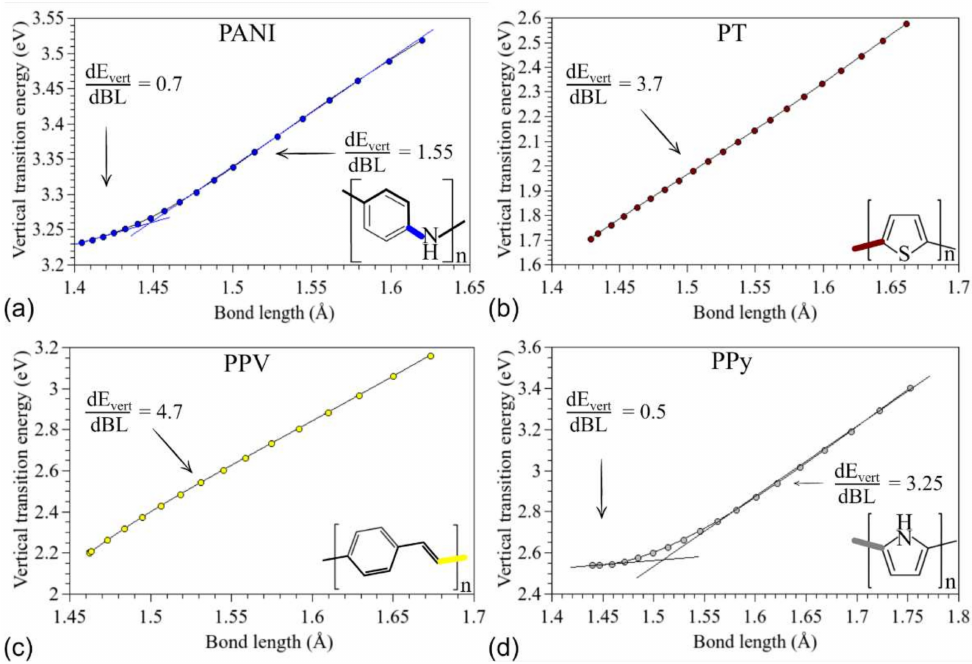
Figure 9. Relationships between the vertical transition energies and the most affected connections in the stretching process: ( a ) PANI, ( b ) PT, ( c ) PPV, and ( d )